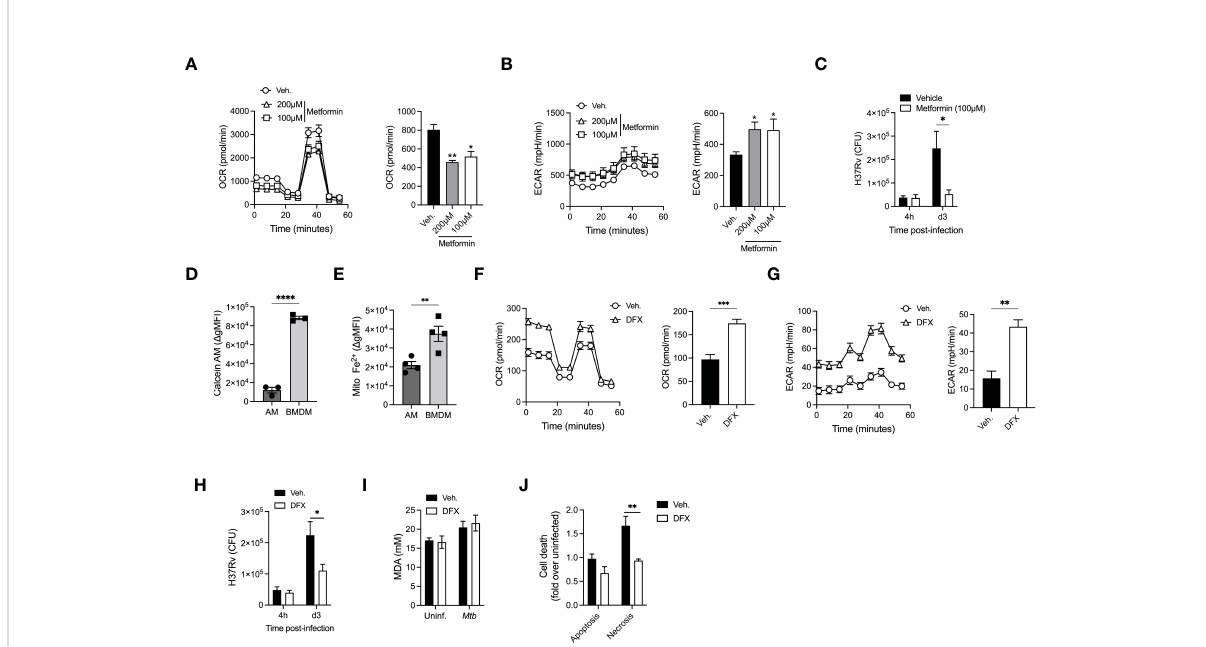
FIGURE 4 AM metabolic reprogramming enhance their killing capacities. (A, B) Alveolar macrophages were treated with Metformin (100µM or 200µM) before cellular metabolism, OCR (A) and ECAR (B) was evaluated using SeaHorse. (C) Metformin-treated AM (100µM) were infected with H37Rv (MOI=1) and bacterial loads were evaluated at different days post-infection. (D, E) Geometric mean fl uorescence intensity (gMFI) of Calcein-AM loaded (D) or mitochondrial iron speci fi c dye RPA stained (E) AM (SiglecF + CD11c + from BAL) or BMDM (CD11b + F480 + ). (F, G) AM were pretreated with desferrioxamine (DFX, 100µM, 24h) and cellular metabolism- OCR (F) and ECAR (G) were evaluated. (H) DFX-pretreated AM (100µM, 24h) were infected with H37Rv (MOI=1) and bacterial loads were enumerated at different days post-infection. (I) Levels of Malondialdehyde (MDA) to measure lipid peroxidation in AM pretreated with DFX (100µM, 24h) after infection by H37Rv (MOI=10, 24h p.i). (J) Levels of apoptosis and necrosis in AM treated with DFX after infection by H37Rv (MOI=10, 24h p.i). Data are representative of 3-4 independent experiments. *p<0.05; **p<0.01; ***p<0.001; ****p<0.0001 determined by 1-way ANONVA followed by Dunnett ’ s multiple comparison, unpaired t-test or 2-way ANOVA followed by Tukey ’ s or Sidak ’ s multiple comparison